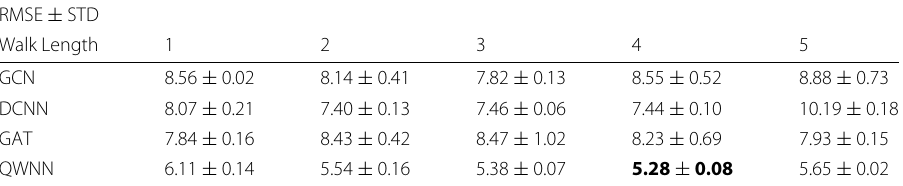
Table 1 Temperature prediction